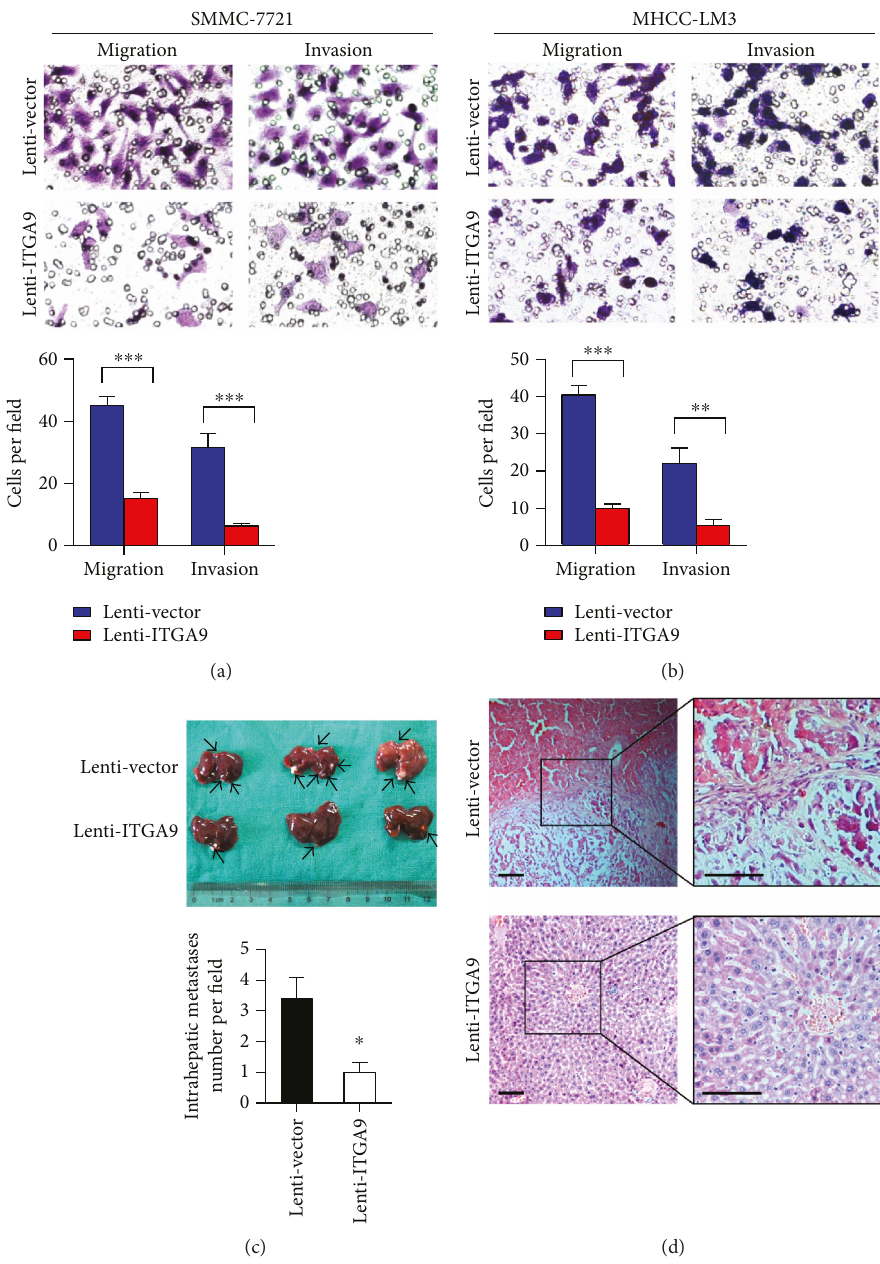
Figure 4: ITGA9 suppresses HCC cell motility in vitro and in vivo . (a and b) Transwell migration and invasion assays in ITGA9- overexpressed or control HCC cells. Quanti fi cation of 6 randomly selected fi elds in each assay. Original magni fi cation: 200x. (c) In vivo orthotopic metastases of ITGA9-overexpressed versus control HCC cells. Black arrows indicate metastases. (d) H&E staining of the mouse liver tissues. Scale bars, 100 μ m. Data are obtained from three representative experiments. Values are means ± SEM. ∗ P < 0 05 , ∗∗ P < 0 01 , and ∗∗∗ P < 0 001